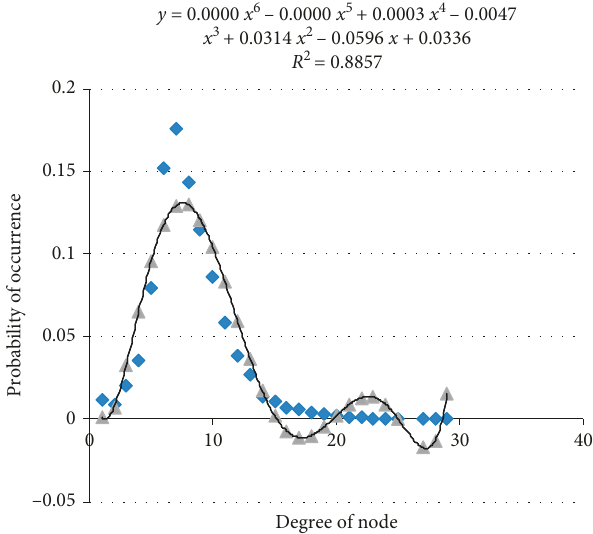
Figure 9: Polynomial curve fitting.